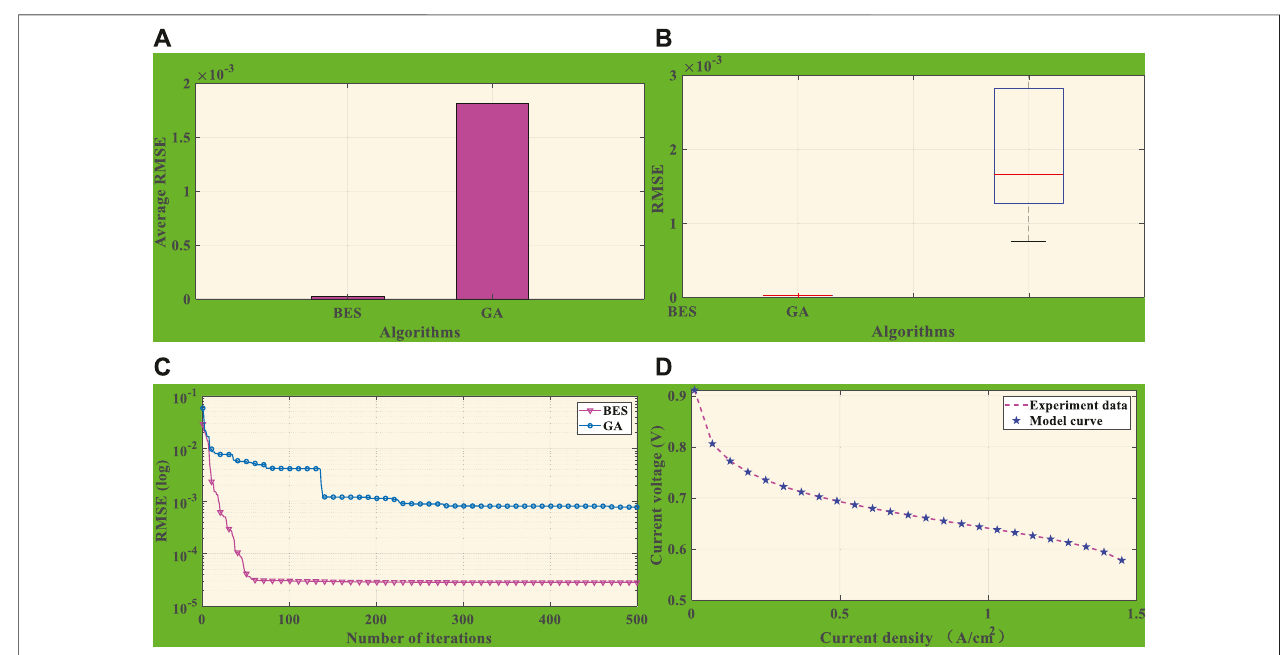
Bold values represents the best results.